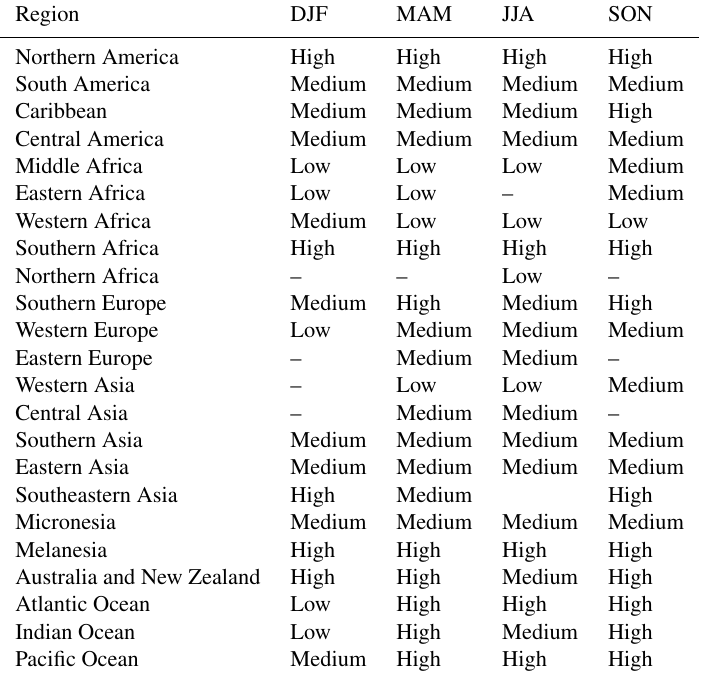
Table 3. Indication of the observed ratio of LCC( > 9ms) to total lightning by region and season. High, medium, and low values correspond to values greater than 10 − 1 , between 3 × 10 − 2 and 10 − 1 , and lower than 3 × 10 − 2 , respectively. The – symbol represents no